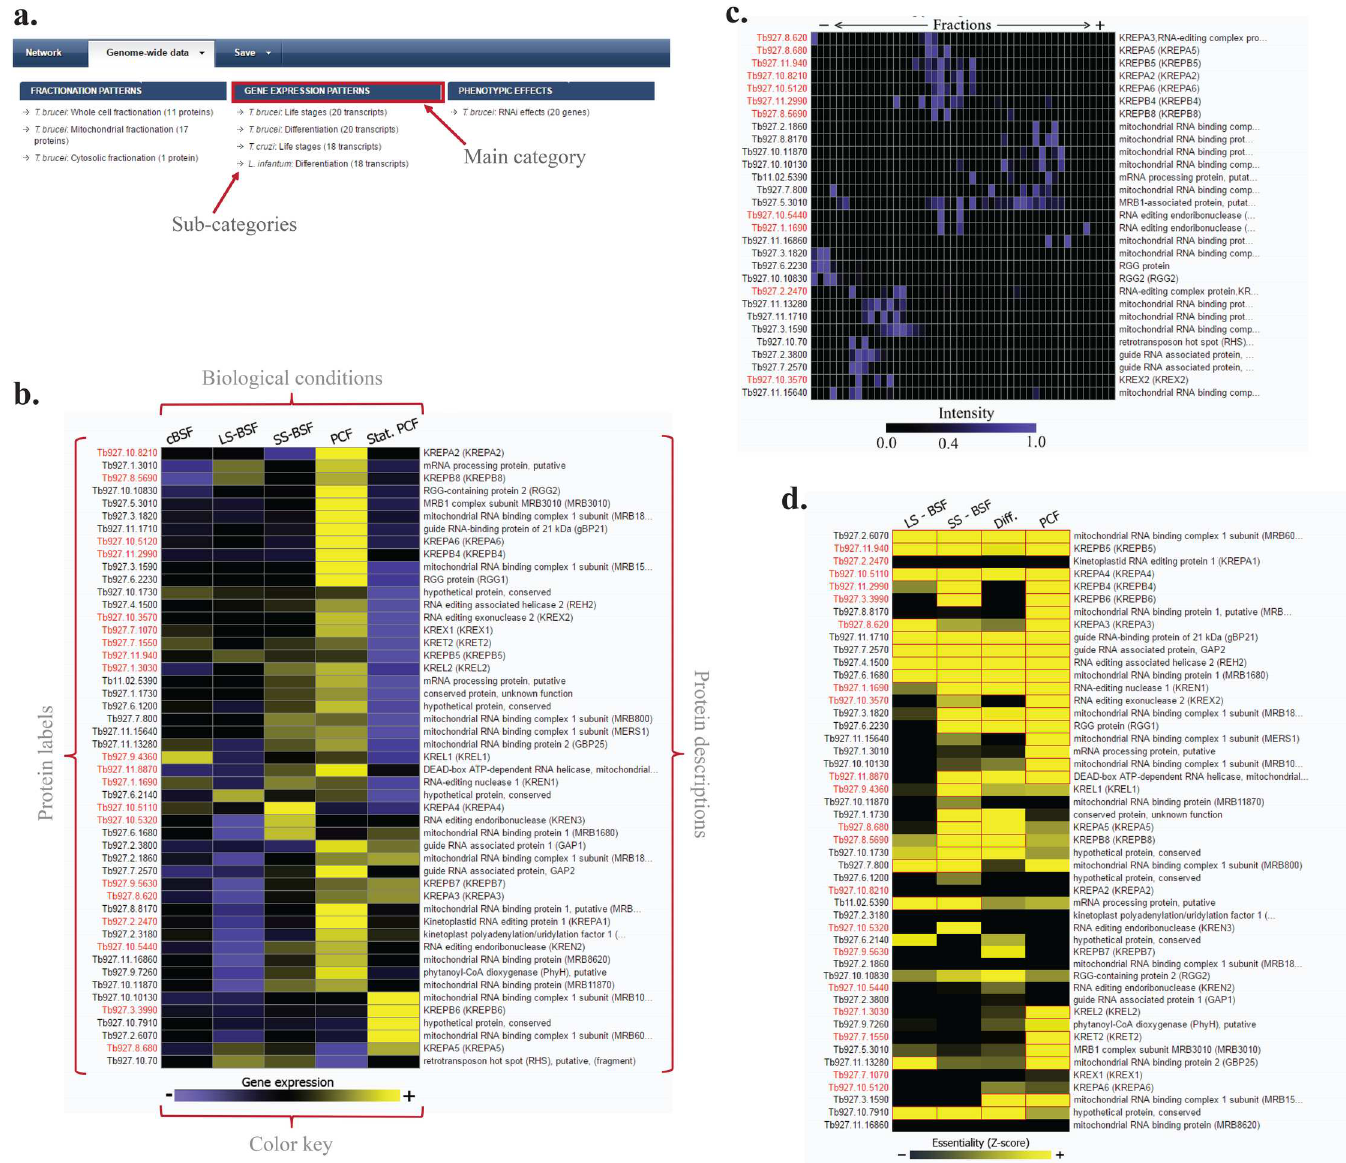
Fig 3. Genome-wide section of TrypsNetDB. (a) Genome-wide sections can be accessedfrom the menu locatedon the top of the interactionsection. Users can visualizeall relevant data by selectinga category or visualizea more specific dataset by choosingthe corresponding sub-category. (b) A sample representation of transcriptome heatmap. Queriedproteins are highlightedby red labels on the left of the heatmap, while suggestedproteinsby the databaseare shown with black labels.(c) A sample representation of a fractionation heatmap. (d) A sample representation of a gene essentialityheatmap. In each life stage (i.e., each column), statisticallysignificantgenes are representedby red